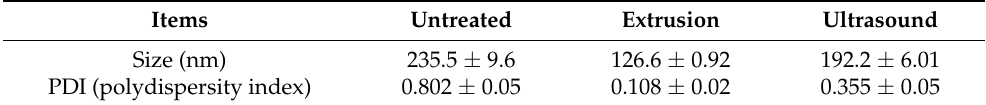
Figure 1. Optimization of cRGD-CL Particle Size. ( A – C ) The hydrodynamic diameter distribution of cRGD-CL. The lyophilized powder of cRGD-CL was detected using Zetasizer Nano ZS90 after rehydration ( A ), ultrasound ( B ) and extrusion ( C ). ( D ) Representative TEM images of cRGD-CL after extrusion. Scale bar: 200 and 50 nm.